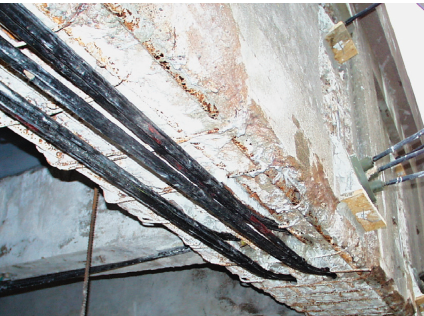
Figure 9: Prestressing tendons composed of individual mono- strands (black HDPE sheaths) on the bottom side of the girder after curvature of their trajectories in saddles [21]. After the prestressing of tendons, the bottom side of the girder is provided with the anchored protective concrete cover layer (the second corrosion protection). The appearance and the concrete character of the bridge are then